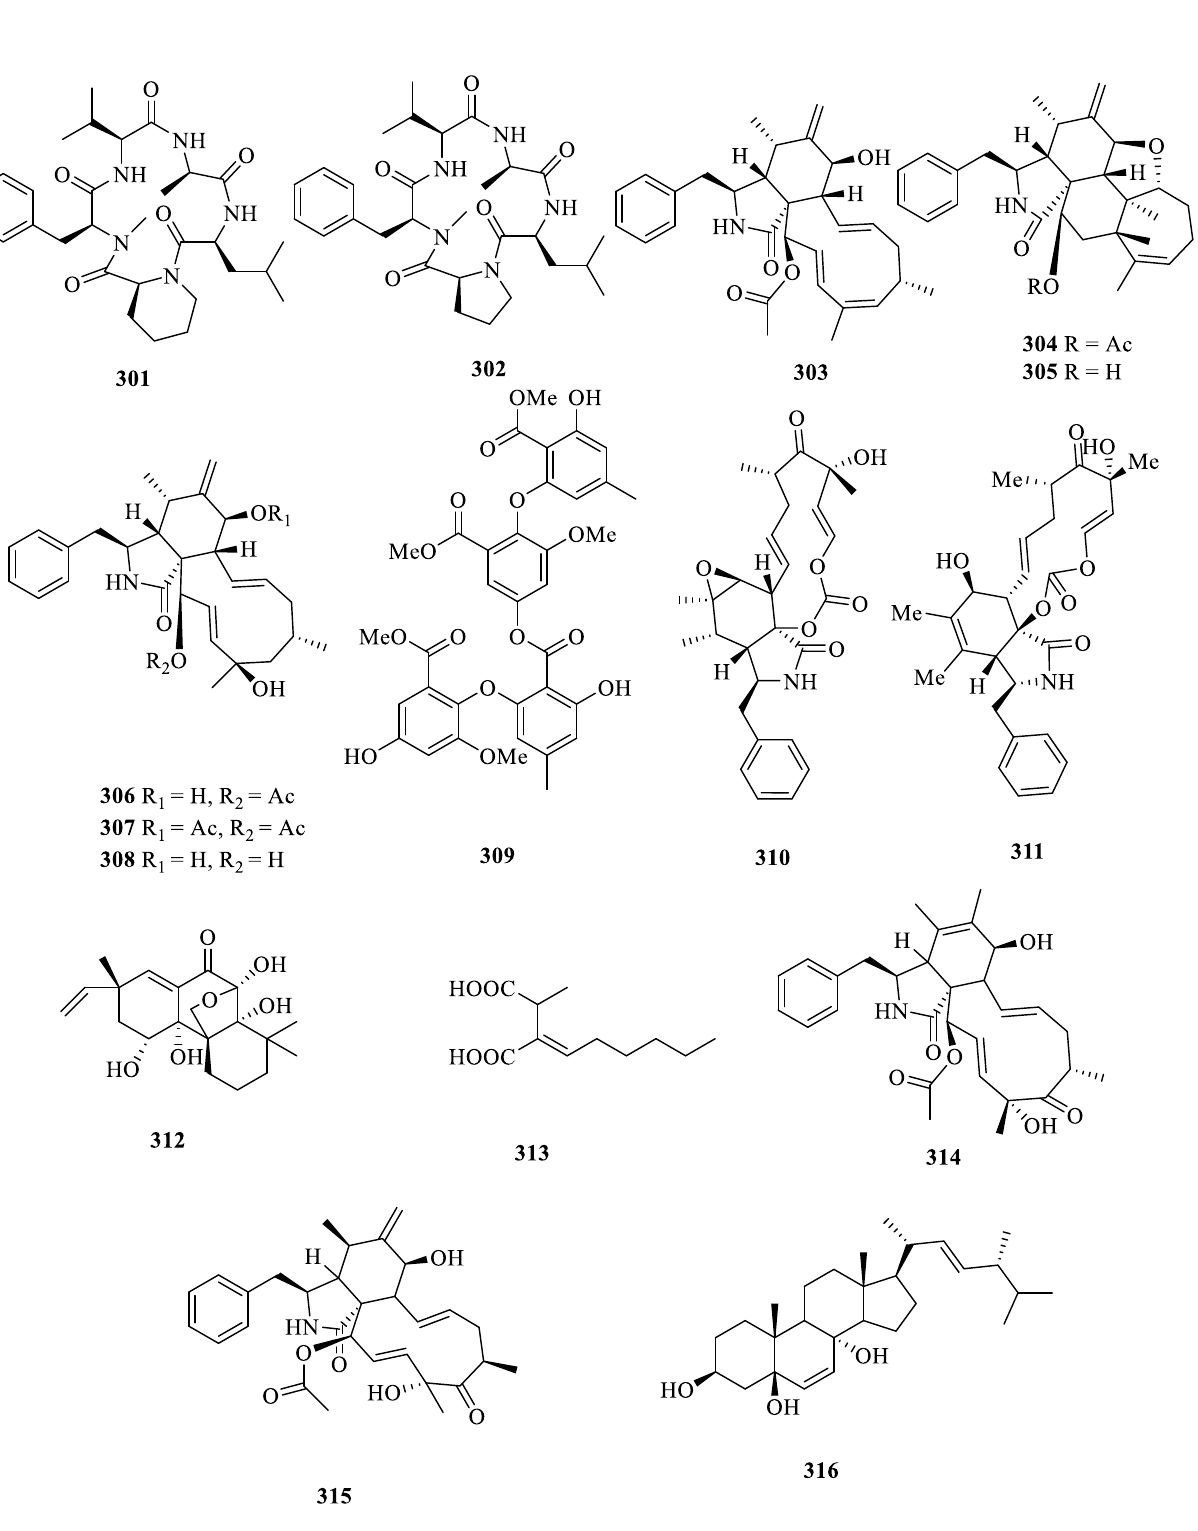
Figure 1. Structures of compounds 1–316 from S. tonkinensis .